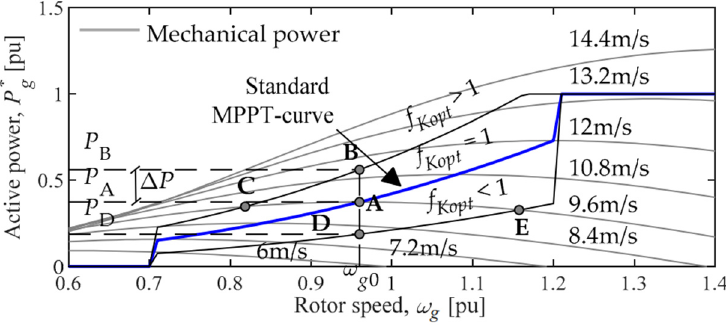
Figure 9. Extended OPPT Method [24].